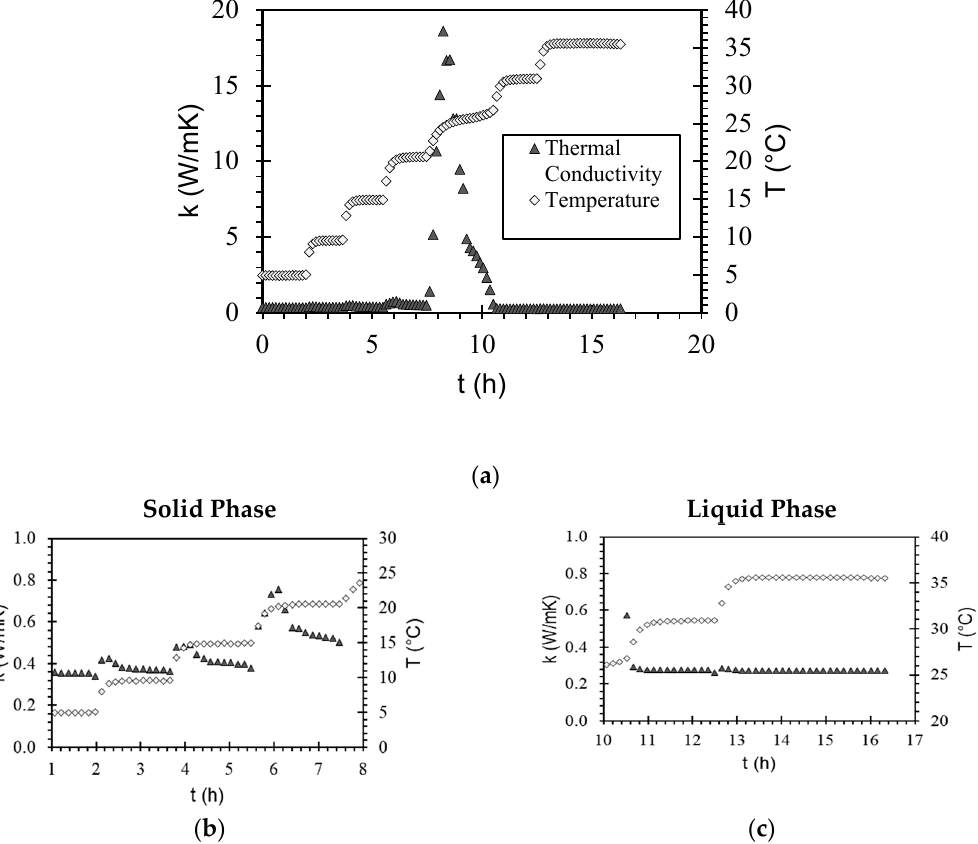
Figure 8. ( a ) Behavior of the thermal conductivity of impregnated wood sample (tangential cut) as a function of time and temperature: ( b ) solid phase details and ( c ) liquid phase details.